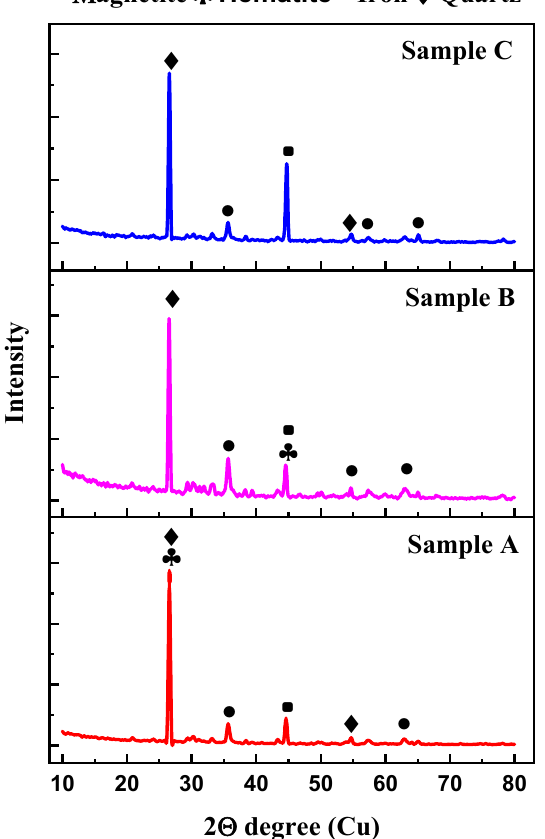
Figure 9. XRD results of concentrate from the drum wet weak magnetic separator.